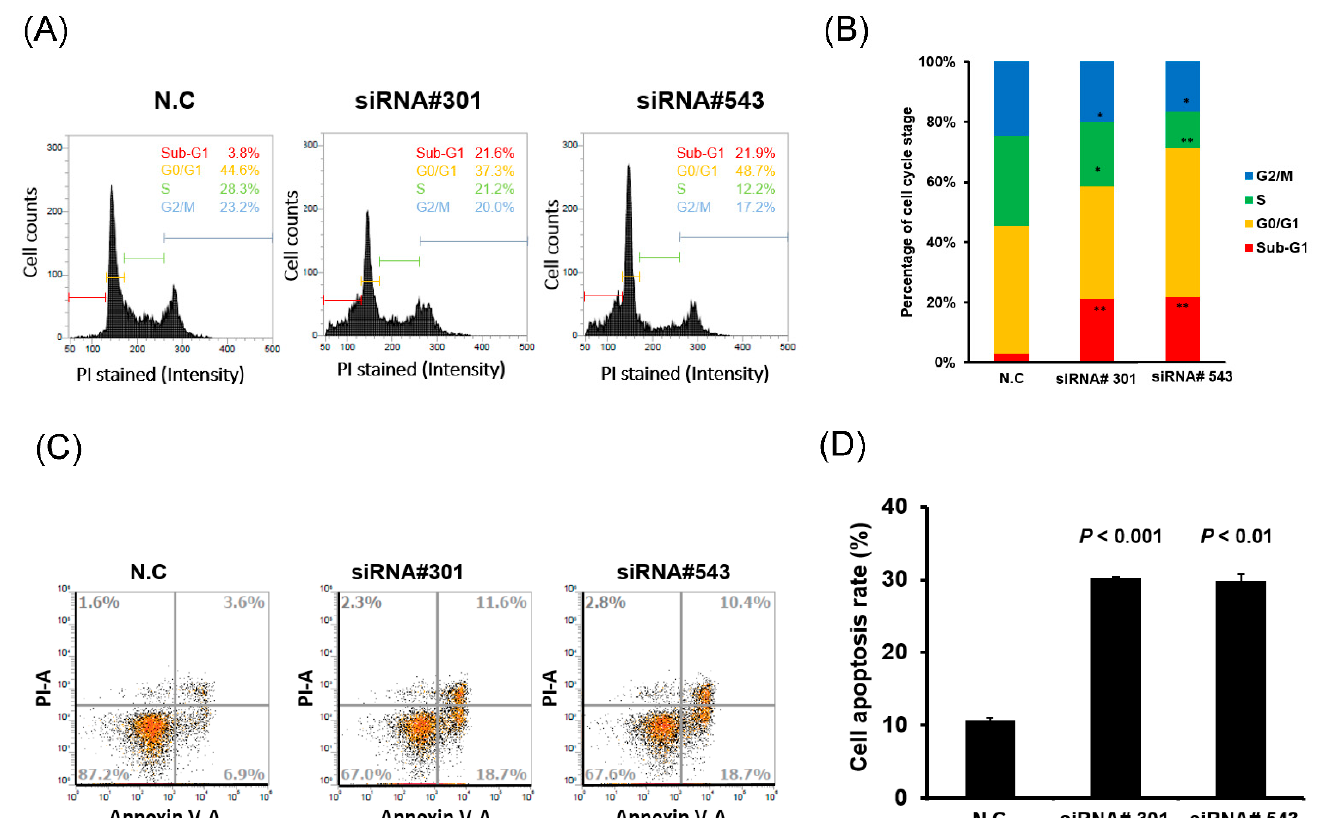
Figure 3. LOC550643 knockdown hindered cell cycle progression and induced apoptosis in colon cancer cells. LOC550643 was knocked down in HCT116 cells through transfection with siRNA-#301, siRNA-#543, or N.C (scrambled control) control. ( A ) Cells in each phase of the cell cycle were analyzed through flow cytometry. ( B ) Cell populations in each phase were quantified using NucleoView NC-3000 software. ( C ) After LOC550643 knockdown for 48 h, cell apoptosis was detected through the annexin V assay. ( D ) The number of apoptotic cells in HCT116 cells with LOC550643 knockdown and in control cells was quantified (N.C group). Experiments were performed in triplicate, and data were analyzed using the student t test. Differences were considered significant at p < 0.05 (* p < 0.05, ** p < 0.01).